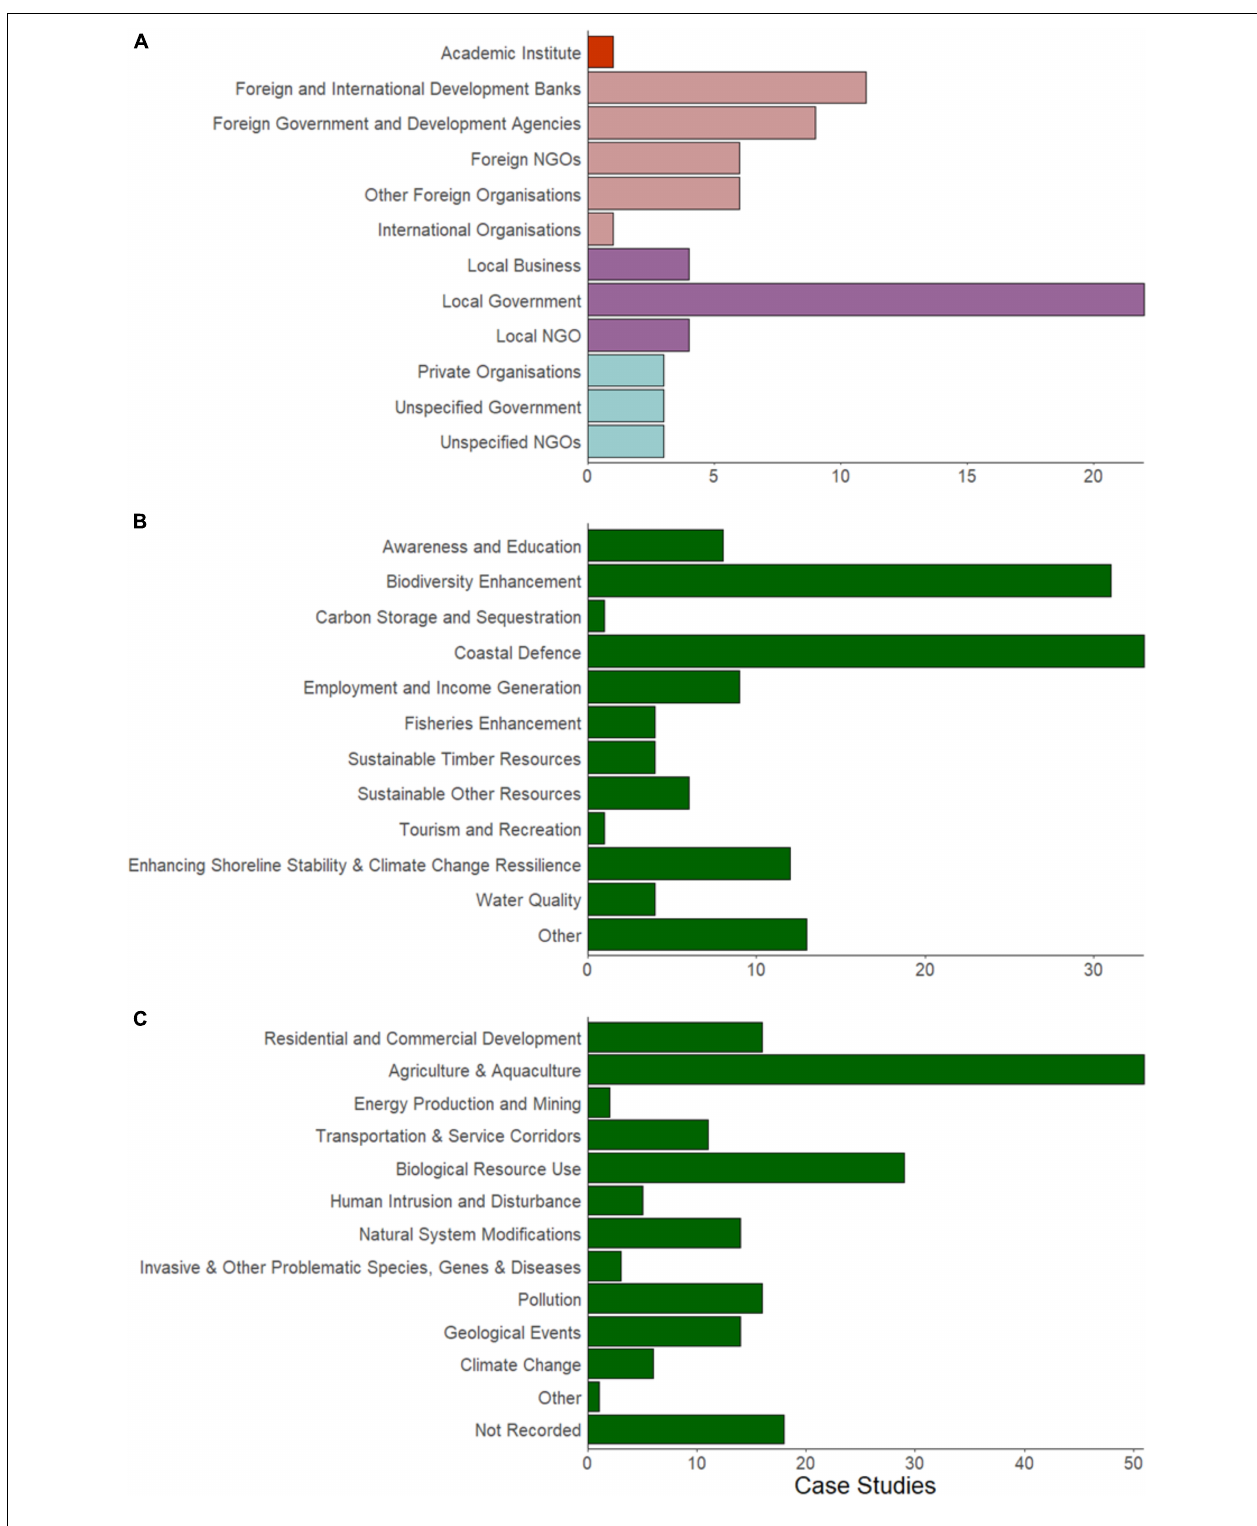
FIGURE 4 | (A) Source of funding recorded from the restoration case studies. The orange bar indicates funding from academic institutes, pink bars indicate funding from a foreign entity, purple bars indicate funding from local entities, light green bars indicate funding from unnamed governments NGOs and organizations. A case study could report multiple sources of funding. (B) Different project aims recorded in the restoration case studies. If a restoration project had more than one aim, all were recorded. (C) Causes of decline recorded in the restoration case studies. A case study could record multiple causes of decline.